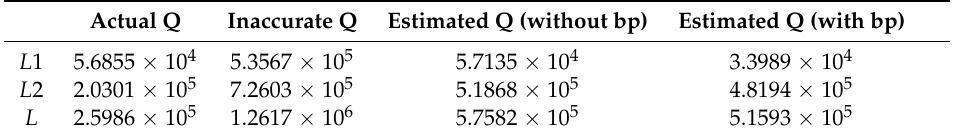
Figure 7. The positioning error of AUV and MRS, in which ( a ) illustrates the horizontal direction of the positioning error components of AUV in global frame; ( b ) illustrates the vertical direction of the positioning error components of AUV in global frame; ( c ) illustrates the horizontal direction of the positioning error components of MRS in global frame; ( d ) illustrates the vertical direction of the positioning error components of MRS in global frame. Table 2. The losses of proposed